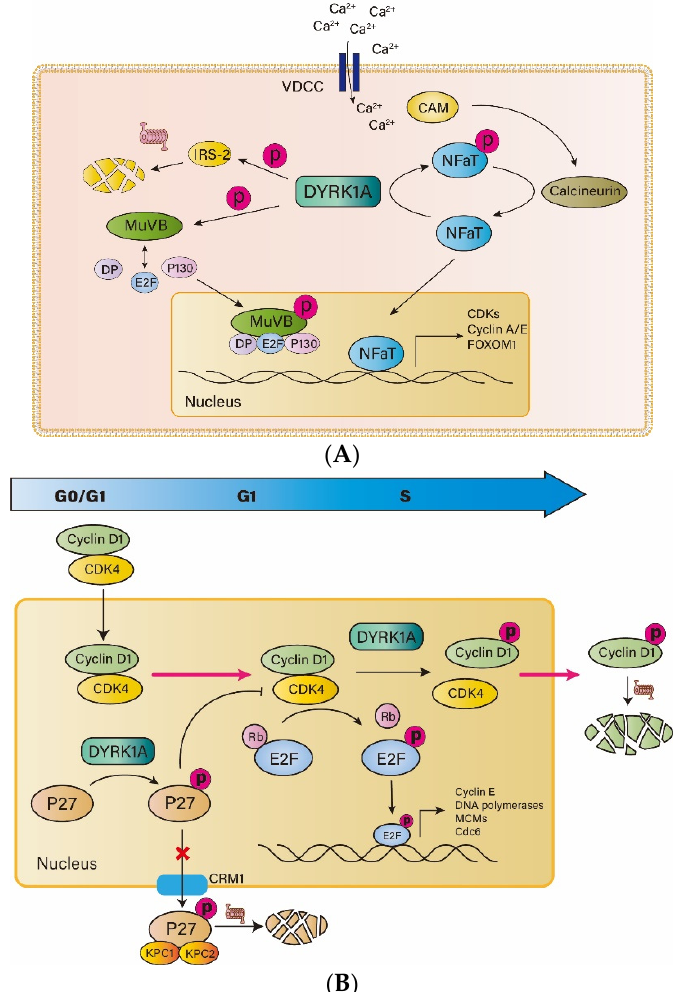
Figure 2. DYRK1A regulates the cell cycle. ( A ) DYRK1A inhibits islet β -cell proliferation by inhibiting NFAT entry into the nucleus, promoting DREAM formation and phosphorylation of IRS-2 for degradation. ( B ) DYRK1A phosphorylates P27 at the G0/G1 phase to stabilize it and prevent its nucleation. In addition, DYRK1A phosphorylates Cyclin D1 during the S phase, promoting its nucleation and degradation. VDCC, voltage-dependent calcium channels; IRS-2, insulin receptor substrate-2; DYRK1A, dual-specificity tyrosine-regulated kinase 1A; NFAT, nuclear factor of activated T cell; CAM, calmodulin; CDK4, cyclin dependent kinase 4; E2F, adenoviral early region 2 binding factor; Rb, retinoblastoma; CRM1, chromosome region maintenance 1; KPC1/2, KIP1 ubiquitination- promoting complex1/2.